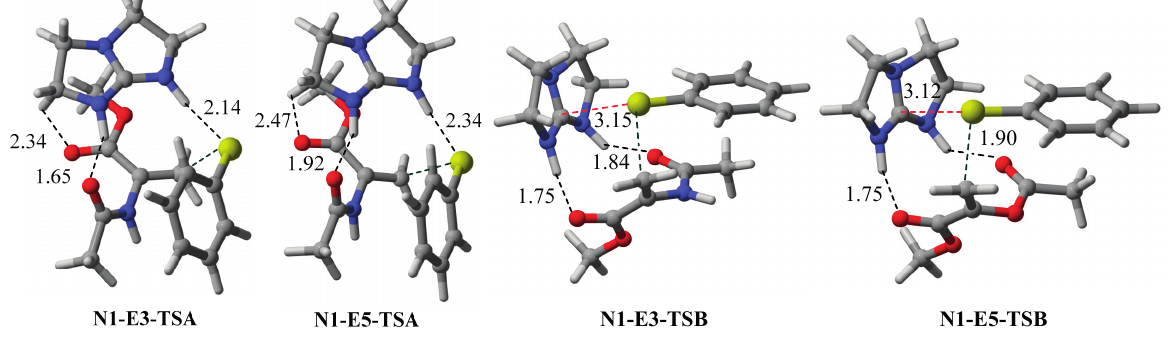
Figure 2. Optimized geometries (M06-2X/6 − 31G*) of TSA and TSB for conjugate addition of E3 and E5 with N1 . C···S, S···H and O···H interaction distances are in